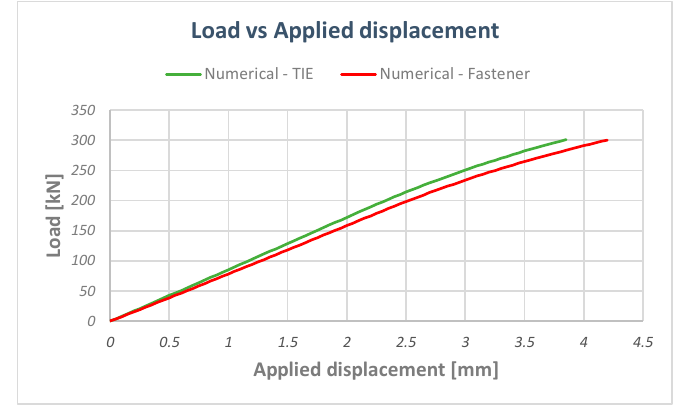
Figure 19. TIE and Fastener numerical models’ stiffness comparisons.